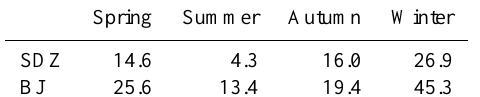
Table 5. Seasonal SO 2 concentrations for sampling periods at SDZ Figure 5. Seasonal concentrations of secondary inorganic ions, TC, and crustal and BJ (µgm − 3 ) . elements at five sites.